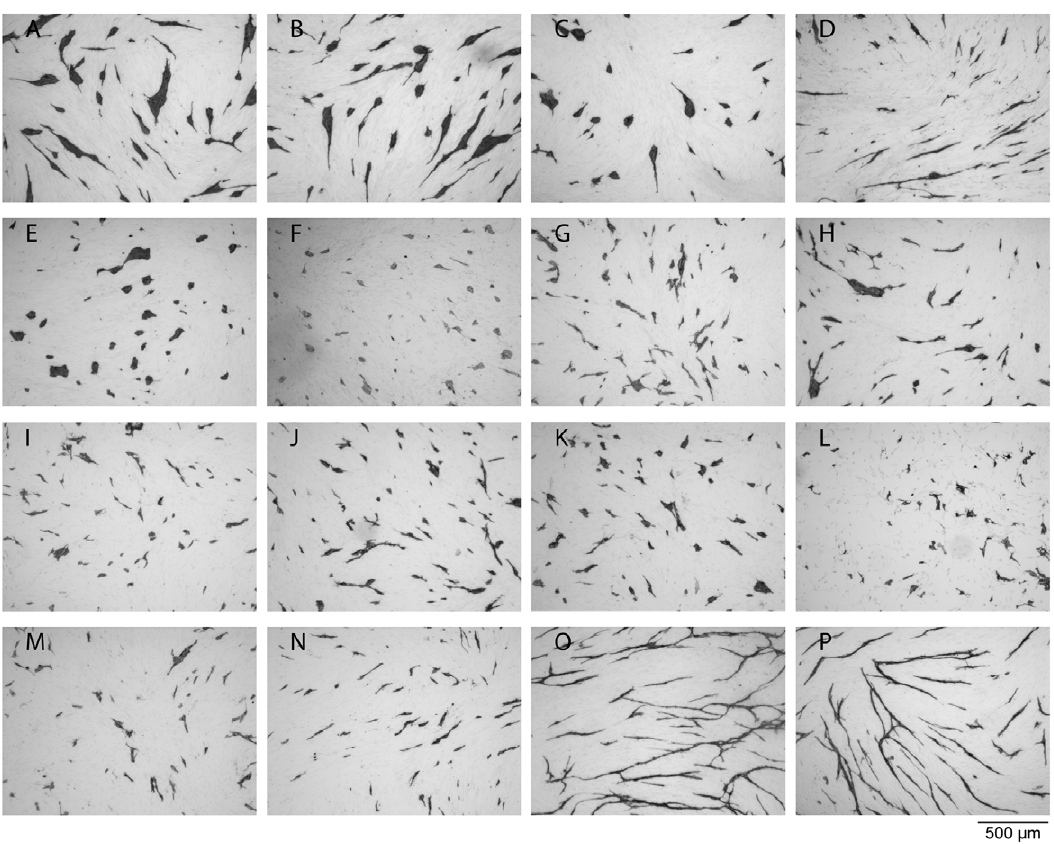
Figure 5. The effect of levamisole and its analogues recorded in the in vitro angiogenesis assay performed with HUVECs growing on a fibroblast monolayer. The images show HUVECs visualized by immunostaining for CD31 after treatment with: A) 1 mM levamisole ( 1 ); B) 1 mM tetramisole ( 2 ); C) 1 mM p -bromolevamisole ( 3 ); D) 1 mM compound 4; E) 1 mM N -methyllevamisole triflate ( 7a ); F) 0.7 mM N - methyllevamisole trifluoroacetate ( 7b ); G) 0.2 mM N -ethyllevamisole trifluoroacetate ( 8b ); H) 0.7 mM N -ethyllevamisole iodide ( 8a ); I) 0.6 mM N - isopropyllevamisole trifluoracetate ( 9 ); J) 0.3 mM N -butyllevamisole trifluoroacetate ( 10 ); K) 0.4 mM N -benzyllevamisole trifluoroacetate ( 11b ); L) 0.7 mM N -benzyllevamisole bromide ( 11a ); M) 0.1 mM N -cyclohexylmethylenelevamisole trifluoroacetate ( 12 ); N) 1 mM suramin ( 5 ); O) medium (control); P) 0.1 % DMSO (the control was diluted 1:1000 corresponding the concentration of DMSO present when testing 1 mM of a compound diluted from a DMSO stock